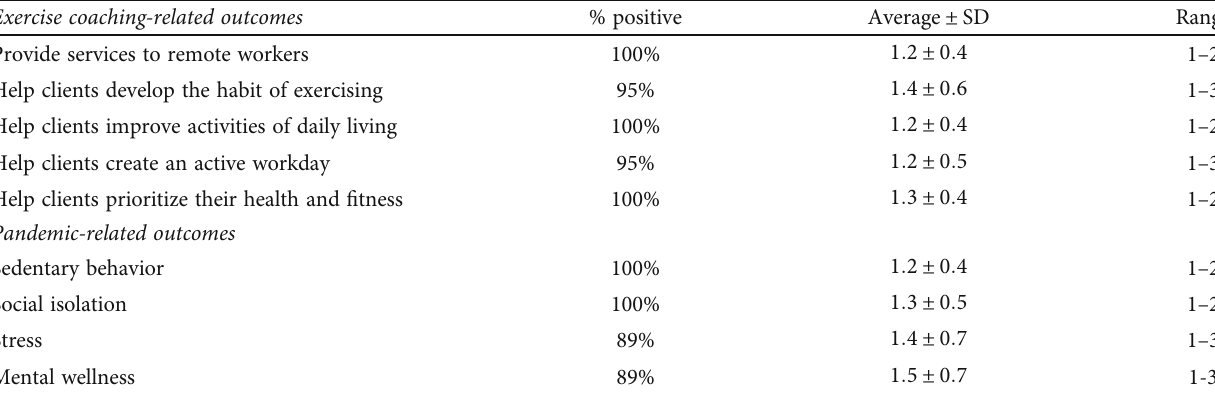
Table 2: Development of remote exercise coaching and pandemic-related